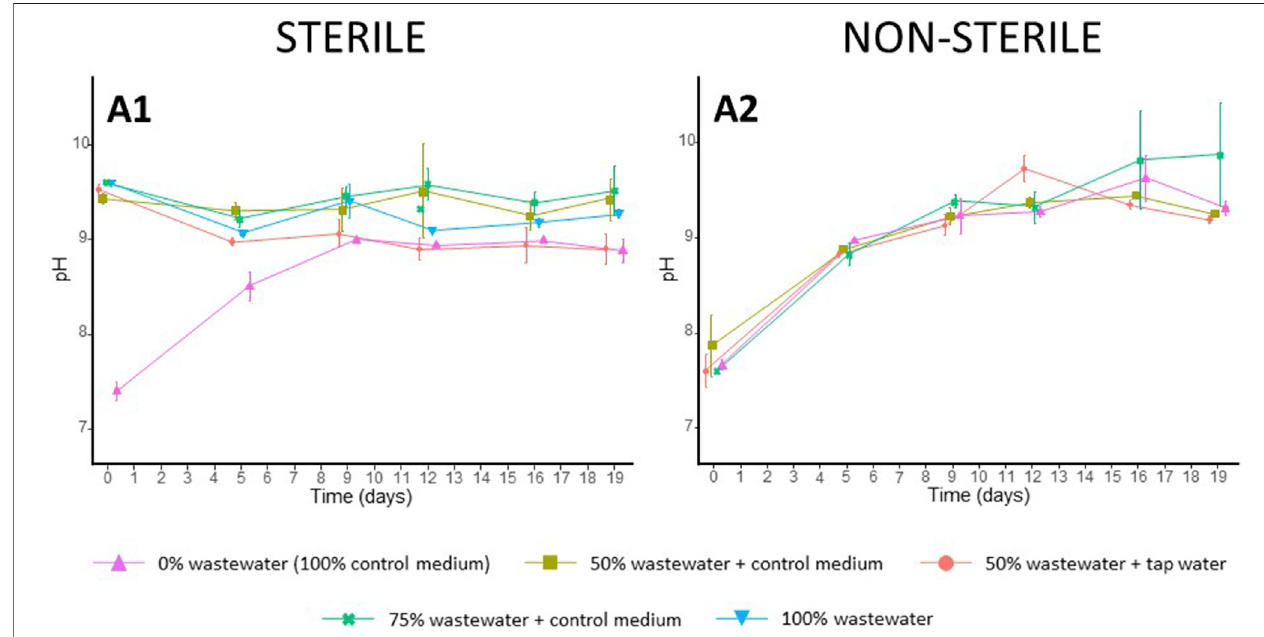
FIGURE6| AveragechangeinpHofthedifferentgrowthmediaovertime. (A1) sterileconditions, (A2) non-sterileconditions.Theresultsaregivenastheaverageof three values, and whiskers delineate the standard deviation.